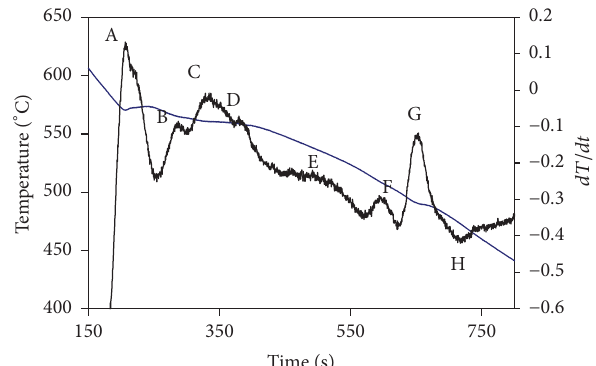
Figure 2: Solidification curve and its 1st derivative obtained from DCM5